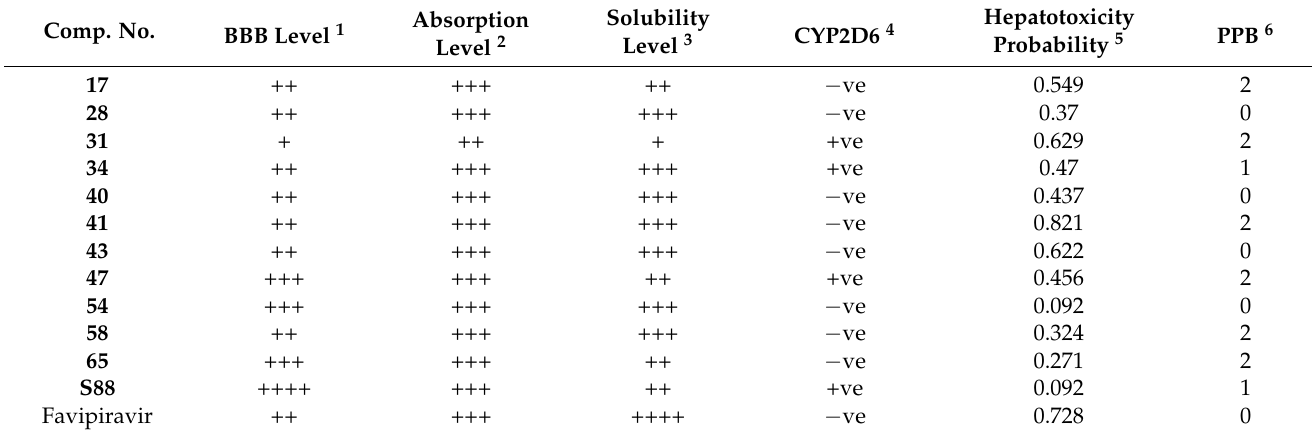
Table 3. Predicted ADMET descriptors for the examined compounds, S88 , and favipiravir. Comp.